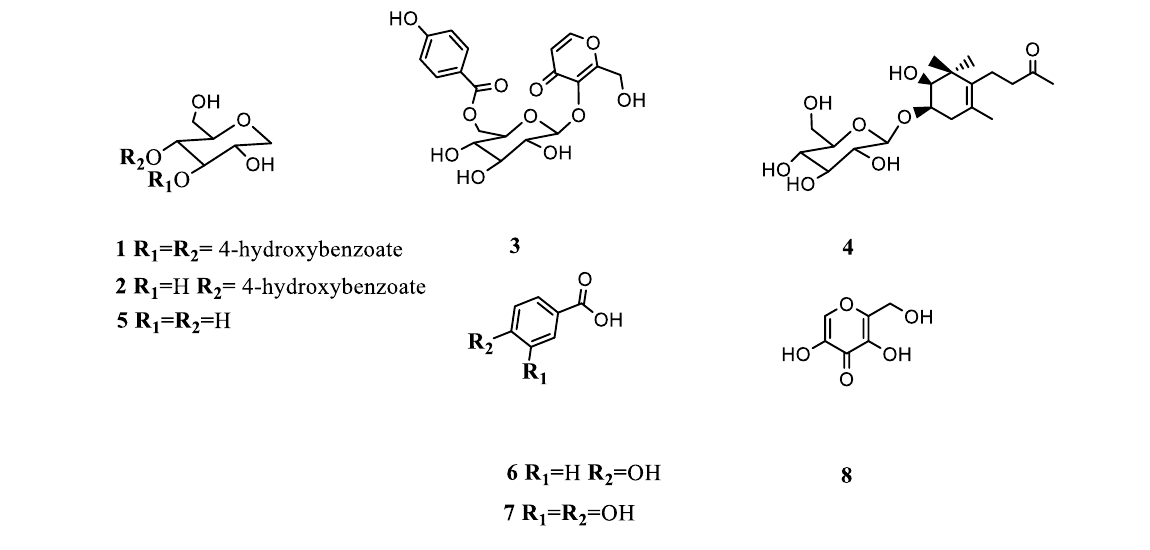
Figure 1. Chemical structures of the isolated compounds ( 1 – 8 ) from P. cynaroides . Structural Elucidation of the Isolated Compounds Compound 1 was obtained as light-brown crystals. The molecular formula was estab- lished as C 20 H 20 O 9 by the positive-ion HRESI-MS, which showed molecular ion [M+H] + at m / z 405.1195 (calc. for 404.3742). The IR spectrum of 1 showed absorption bands for the hydroxyl groups (3335 cm − 1 ), conjugated ester (1693 cm − 1 ), α , β -unsaturated carbonyl (1633 cm − 1 ), and aromatic C=C (1600 cm − 1 ) functionalities. The 1 H NMR data (Table